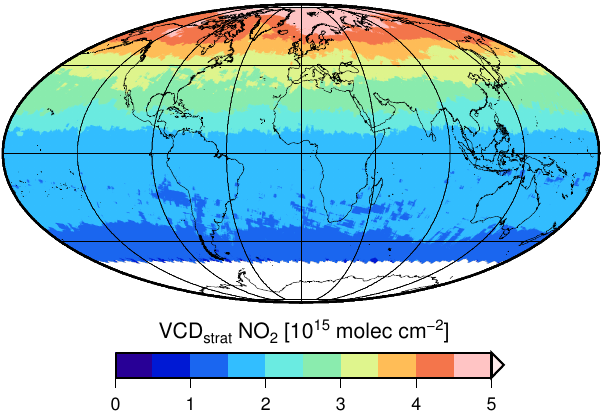
Fig. 3. Monthly averages of VCD limb strat NO 2 from SCIAMACHY limb measurements for June 2010, interpolated to the locations of the SCIAMACHY nadir measurements, and binned to 0.125 ◦ .